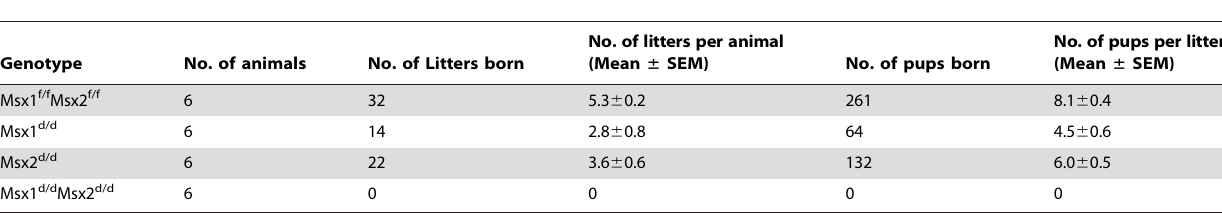
Table 1. Ablation of uterine Msx 1 and Msx 2 leads to female infertility.